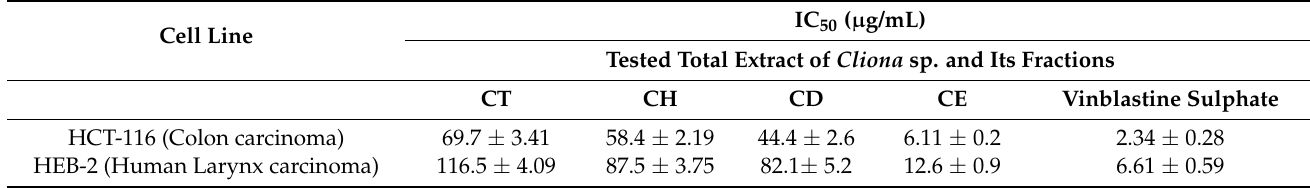
Table 5. Half maximum inhibitory concentration (IC 50 ) of Cliona Sp. Total extract (CT), Hexane (CH), Dichloromethane (CD), and Ethyl acetate (CE) fractions in cell viability of HCT-116 and HEP-2 cells after the treatment for 48 h, as measured by MTT assay. The data are presented as µg/mL. Cell Line solvent system consisted of (A) water containing 0.1% formic acid, (B) methanol containing 0.1% formic acid (Ain Shams University, Cairo,